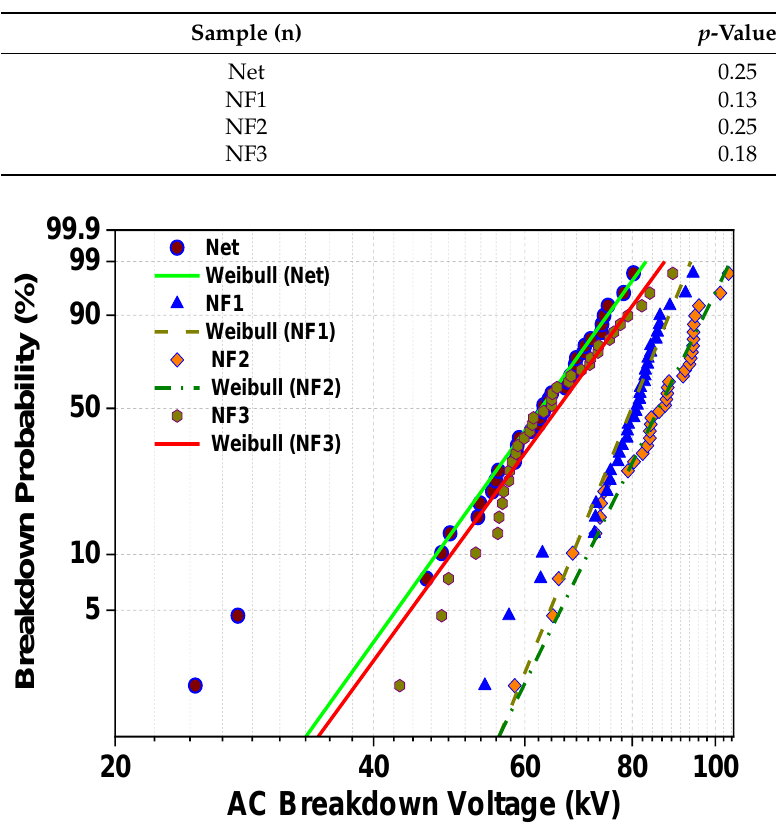
Table 3. Anderson–Darling goodness-of-fit test for the Weibull distribution.